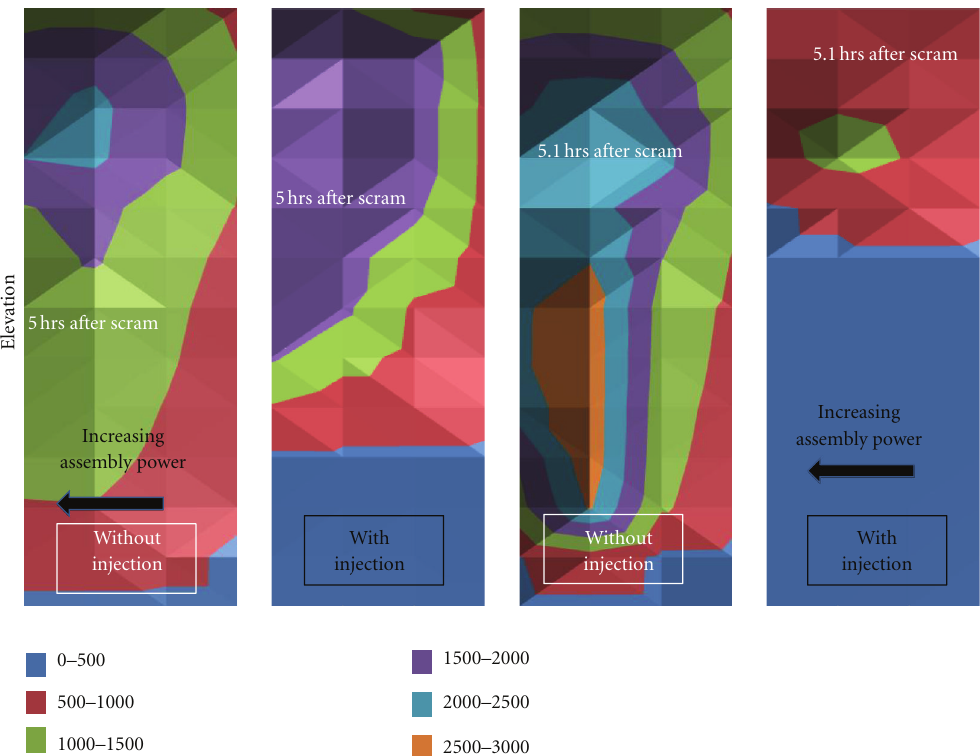
Figure 37: Core temperature distributions for scenarios with depressurization with and without water injection after core uncovery (all emergency water injection was terminated at 4.2 hours after reactor scram).